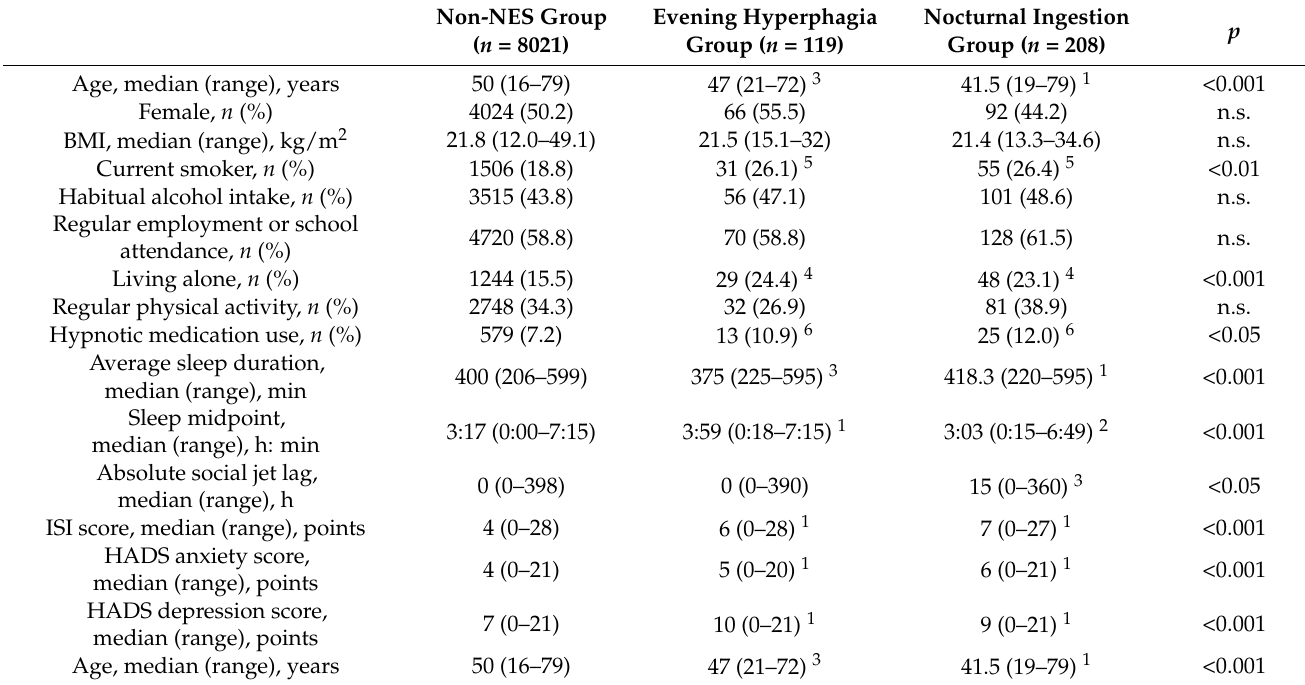
Table 1. Demographic, sleep schedules, and clinical data of the participants ( n =